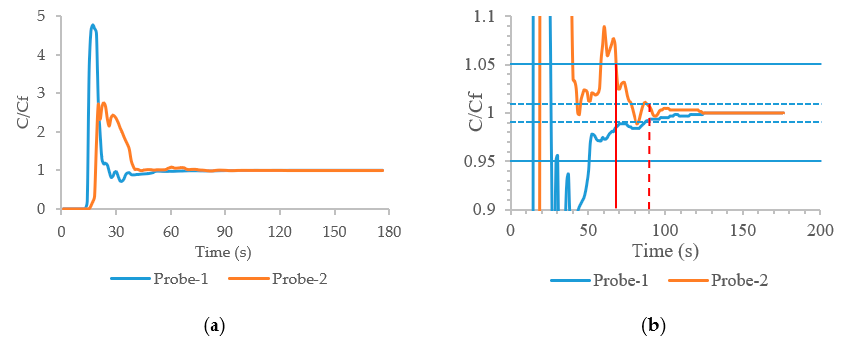
Figure 6. Normalized conductivity curves for two probes for a flow rate of 1.30 L · min − 1 , using a 135 ◦ plug angle. ( a ) Normalized value with whole range. ( b ) Normalized value between 0.9 and 1.1.